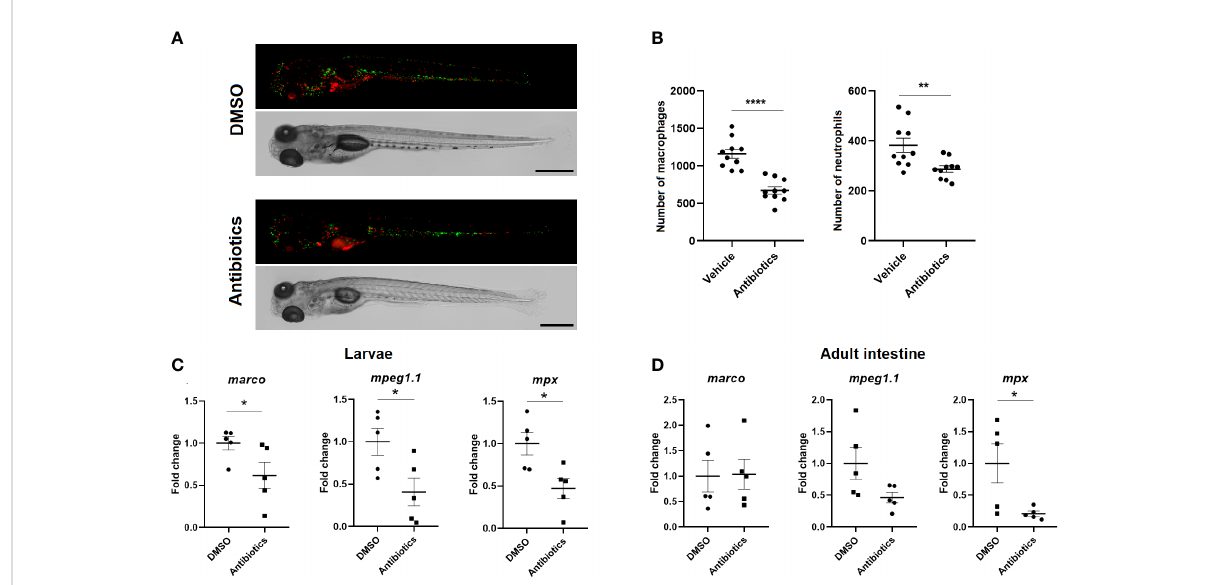
FIGURE 10 Effect of long-term exposure to SMX+CLA on the number of innate immune cells. (A) Representative images of double transgenic Tg(mpeg: mCherry/mpx:GFP) zebra fi sh larvae exposed to vehicle alone (DMSO) or SMX+CLA for 7 days. Scale bar: 500 µm. (B) Macrophage and neutrophil counts in DMSO- and SMX+CLA-treated larvae. Statistically signi fi cant differences are displayed as **** (p<0.0001) and ** (p<0.01). (C) Expression level of the macrophage ( marco , mpeg1.1 ) and neutrophil ( mpx ) gene cell markers in DMSO- and SMX+CLA-treated larvae for 7 days and (D) in the intestine of adult zebra fi sh exposed to the treatments for 2 weeks. Statistically signi fi cant differences are displayed as *